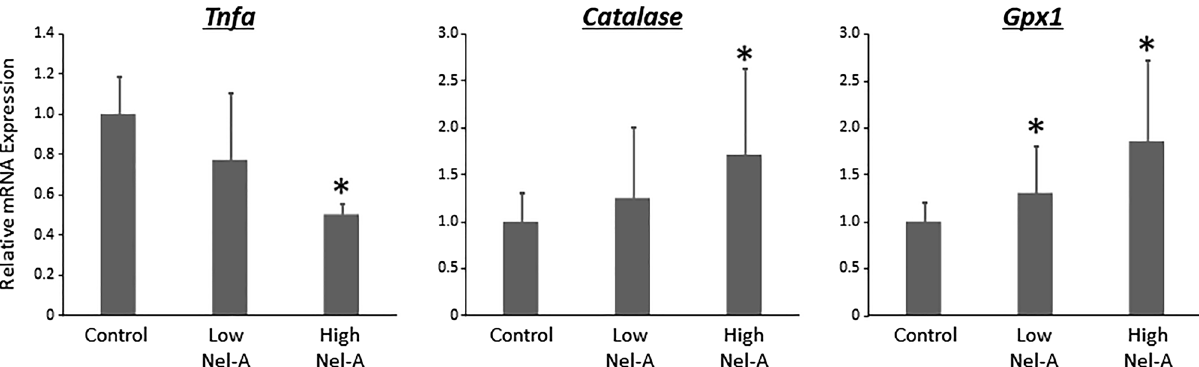
Figure 1. Effects of nelumal A on expression levels of TNF-α and anti-oxidant enzymes in the colon of colitis model mice. The mRNA expression levels of Tnfa , Catalase , and Gpx1 in the colonic mucosa were measured by quantitative real-time reverse transcription PCR with specific primers. Parallel amplification of 18S was used as the internal control. Each column represents the mean ± SD. Asterisk indicates statistically significant differences compared to DSS-treated group; P < 0.05. Statistical analyses were performed using one-way ANOVA followed by Tukey–Kramer multiple comparison test. n = 5. Nel-A, nelumal A.